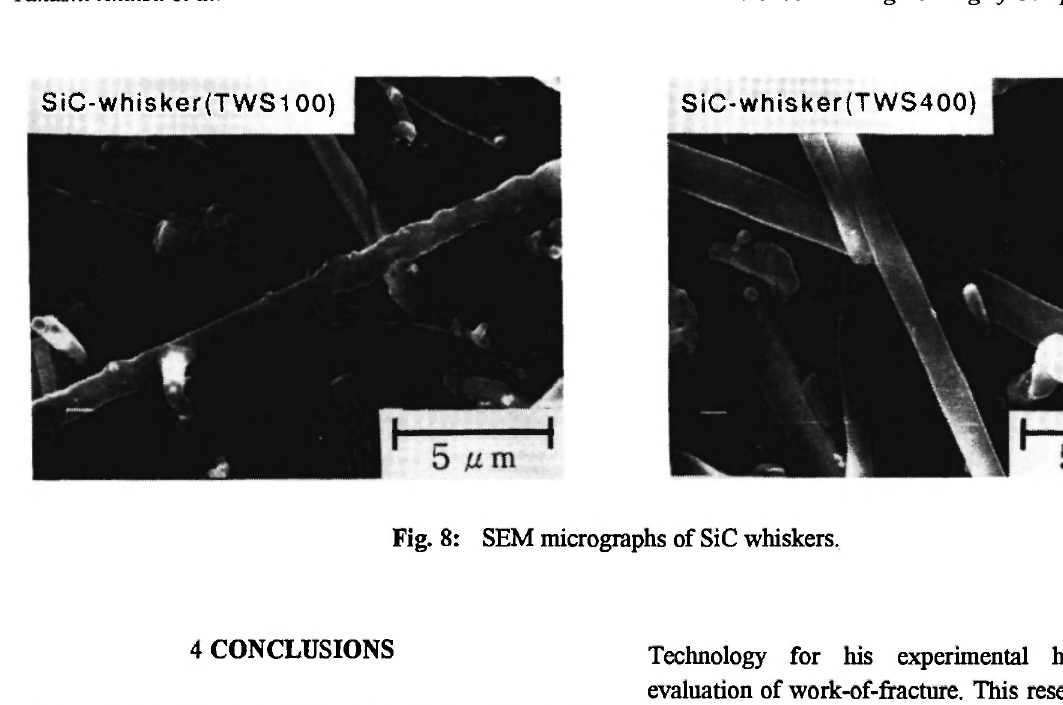
Fig. 8: SEM micrographs of SiC